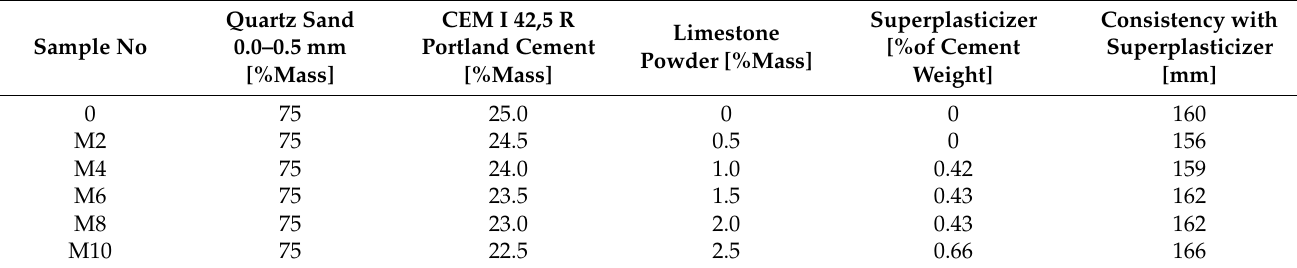
Table 5. Composition of samples modified with limestone powder.